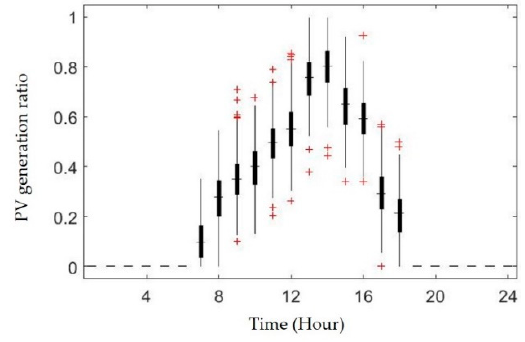
Figure 4. Statistical information on annual PV generation.